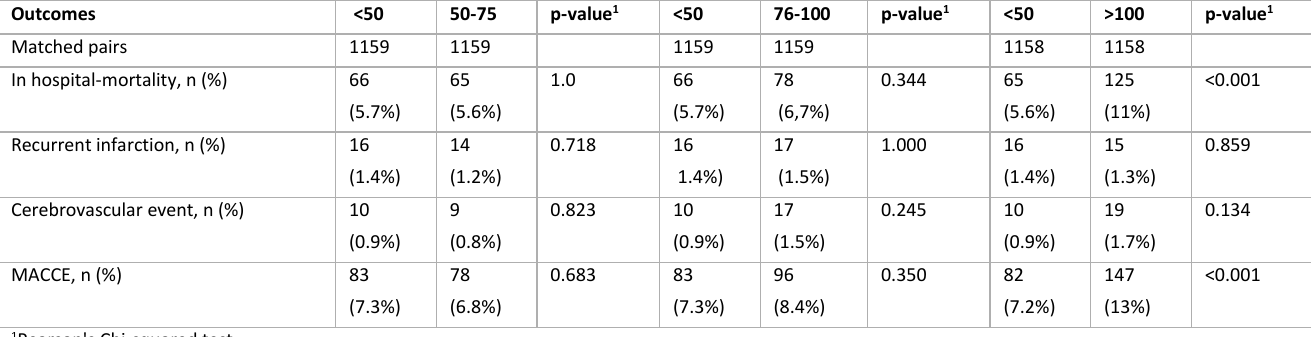
Table 2. In hospital outcomes after propensity score matching. In hospital outcomes of matched groups stratified according to admission HR.